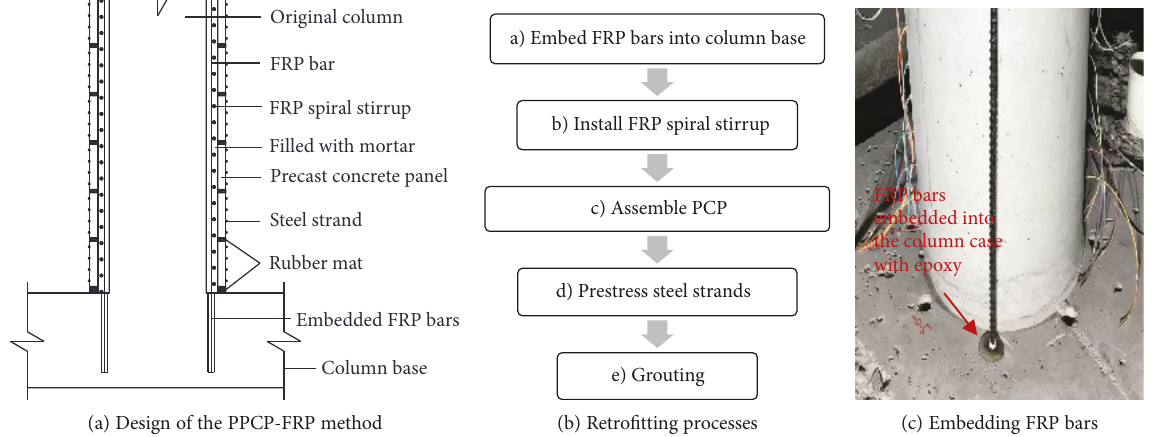
Figure 1: Design and retro fi tting processes of the PPCP-FRP method.